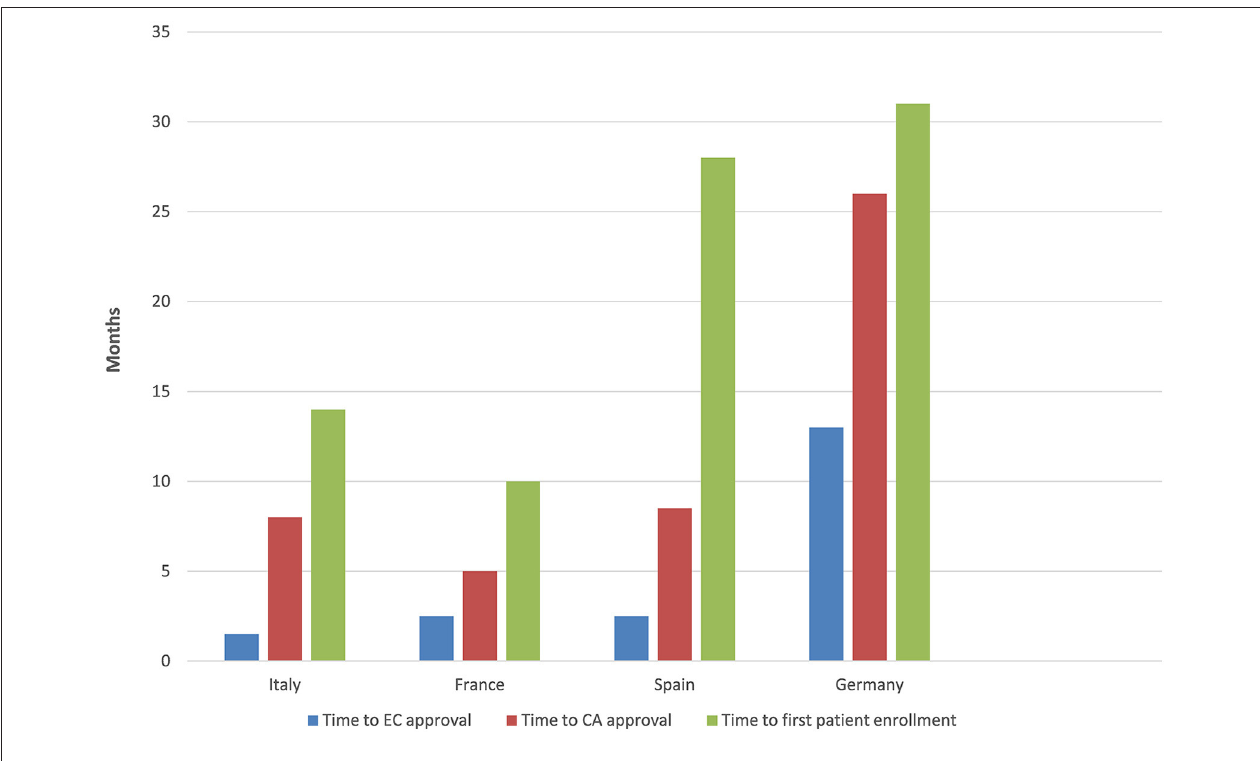
FIGURE 1 | Timelines.